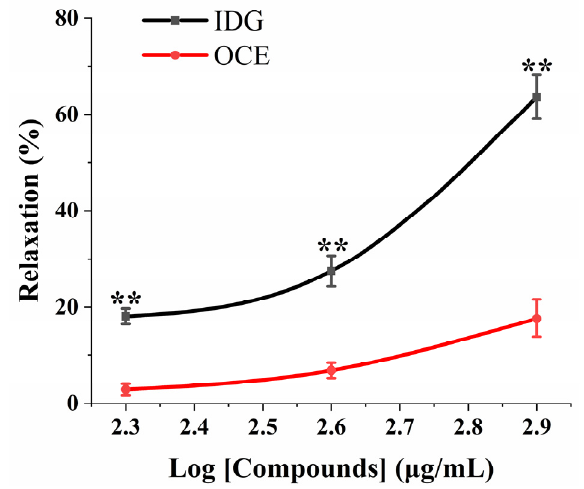
Figure 3. The vasodilatation induced by isodillapiolglycol (IDG) was stronger than that of OCE at the same dose. Endothelium-denuded aorta rings were pre-contracted with NE before the addition of IDG (200, 400, 800 µ g / mL) or OCE (200, 400, 800 µ g / mL). Values are means ± SEM ( n = 6). Note: ** p < 0.01 compared with the OCE group using two-way ANOVA.